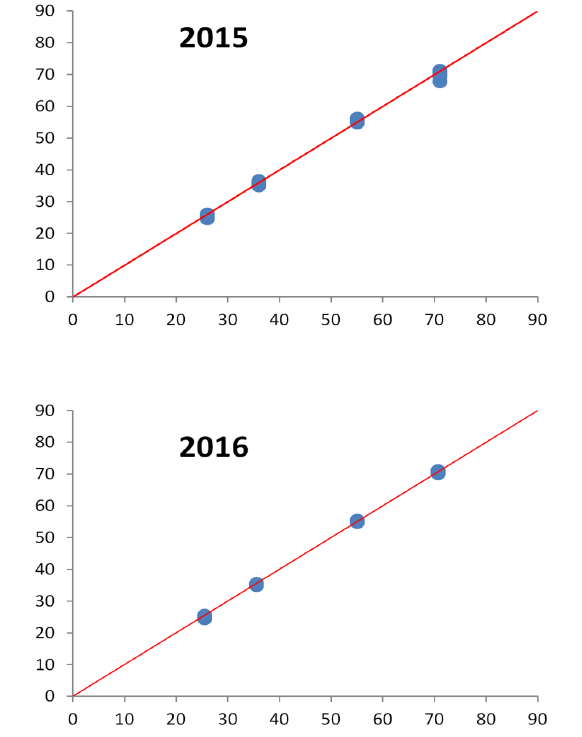
Figure 8. Actual (x-axis, degrees) versus measured declinations using the Geometer in 2015 and 2016. X=Y line shown for comparison. USE ON SURVEYS